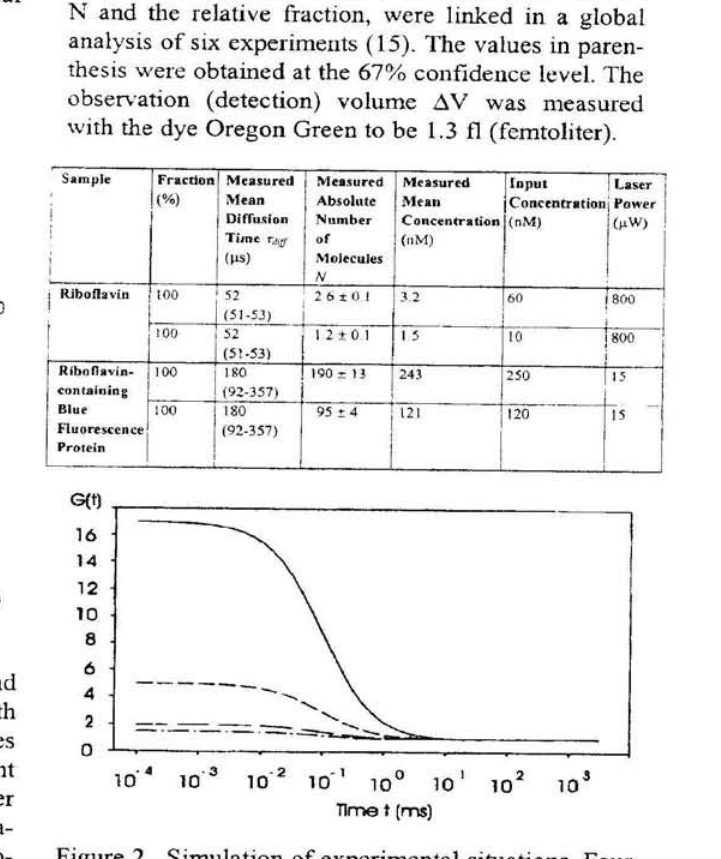
Figure 2. Simulation of experimental situations. Four auto-correlation curves are depicted with different Ν values. N= 2, dash-doted line. N= 1, long-dashed line. Ν = 0.25, short-dashed line. Ν = 0.06, solid line. Only the diffusion process is considered here.